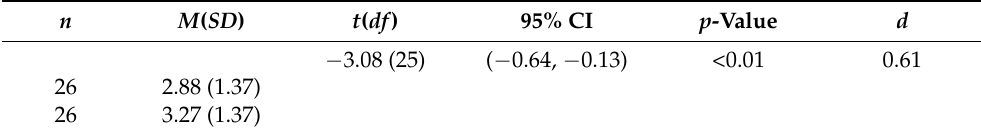
Table 3. Mean differences in paired samples of COVID-19 vaccine